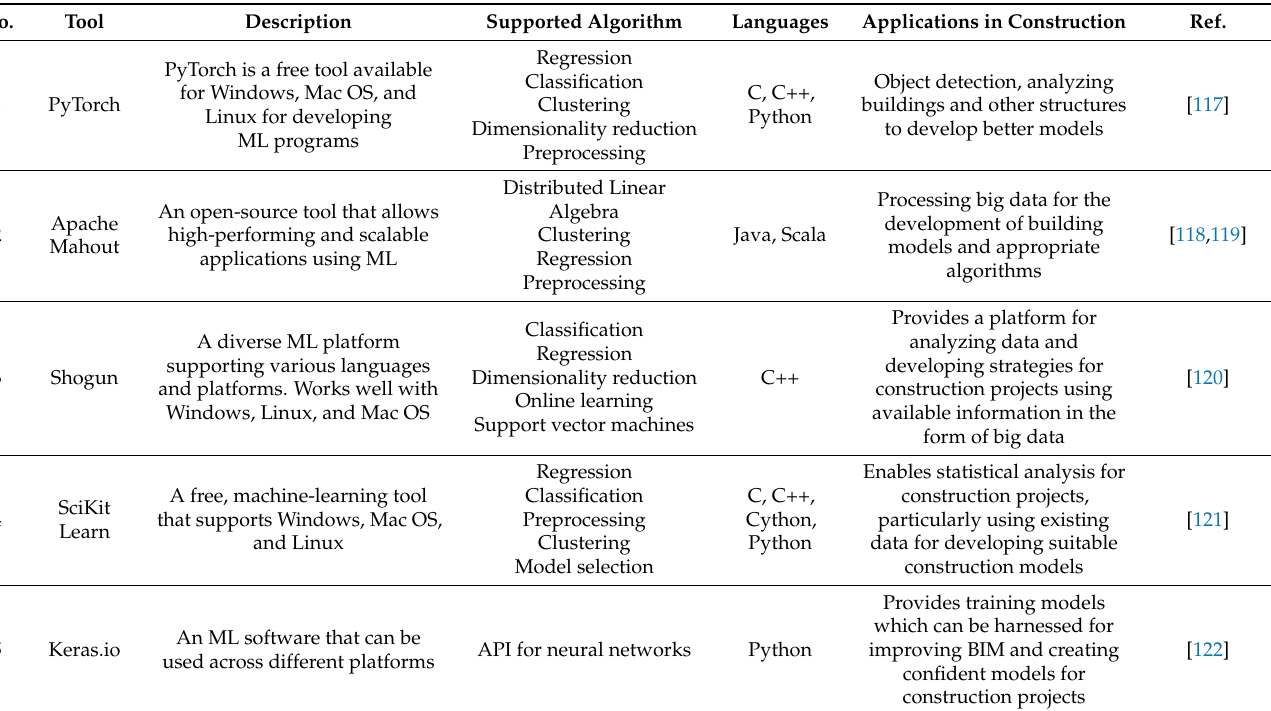
Table 2. Machine learning tools used for big